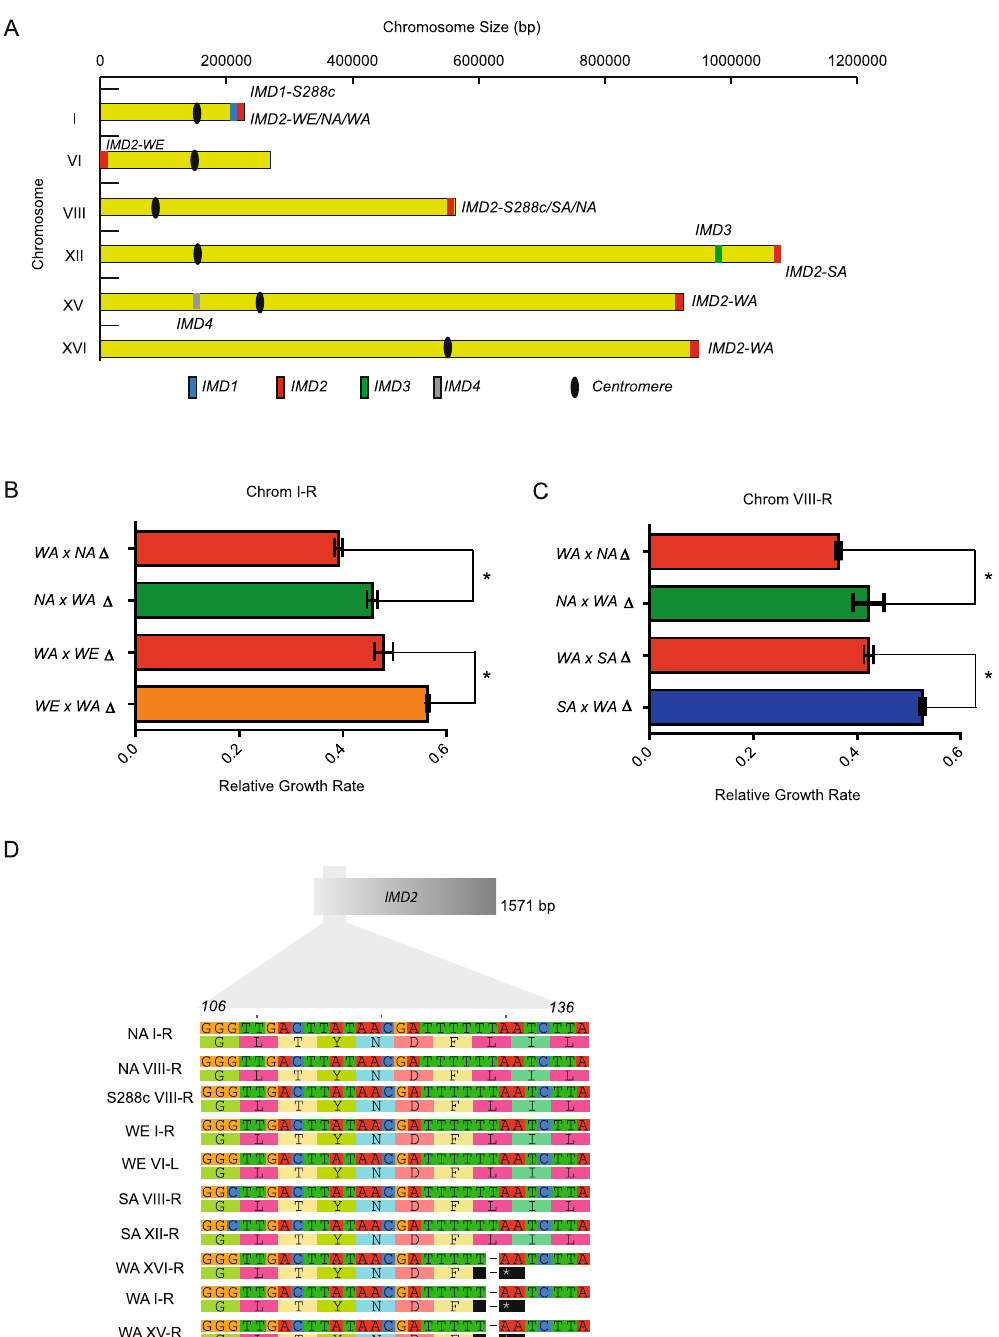
Figure 2. Mapping of the IMD family. ( A ) Physical localisation of IMD1 (blue rectangle), IMD2 (red rectangle), IMD3 (green rectangle), and IMD4 (grey rectangle) across the genomes of the four isolates. Abbreviations denote each isolate type and the black circle depicts the centromere localisation. ( B ) Relative growth rates (estimated as growth rate of isolate subjected to MPA/growth rate of isolate in YPD) of reciprocal hemizygotes for subtelomeres I-R and ( C ) VIII-R ( * ) denotes a significant difference according to a Student’s t-test p-value < 0.05. ( D ) Nucleotide and amino acid Imd2p sequence in the WE, WA, SA, NA and S288c reference isolates, ( * ) denotes a stop